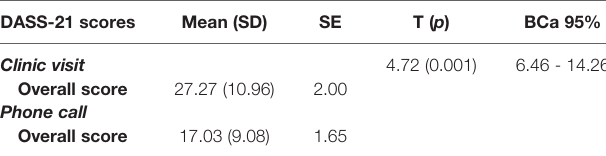
TABLE 5 | Paired-sample t-test for comparing pre-post overall DASS-21 scores (n=30) a